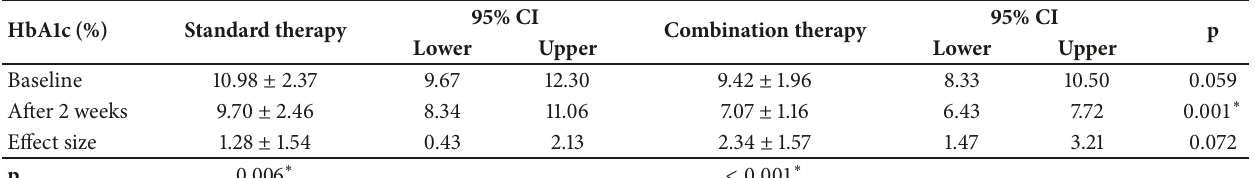
Table 2: HbA1c levels between